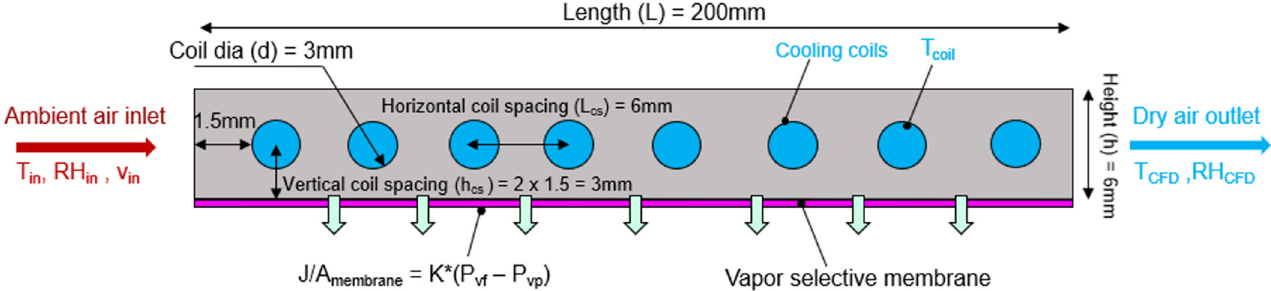
Figure 2. Baseline dimensions of the membrane energy exchanger 2D CFD study. Baseline dimensions are used to initially study membrane energy exchanger performance and are optimized further by CFD parametric sweep results. The boundary conditions used for the CFD model are also shown. The inlet boundary conditions are chosen to represent a warm humid climate at the inlet and typical HVAC operating conditions at the outlet. The inlet boundary condition is maintained at 27 ℃ , 70% RH (relative humidity) for most cases.